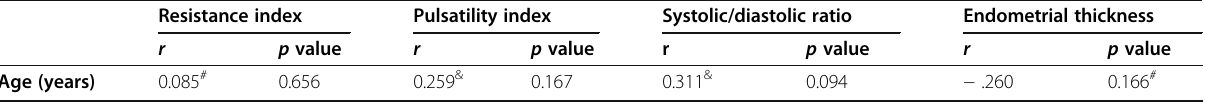
Table 3 Correlation between uterine arteries resistance index, pulsatility index, systolic/diastolic ratios, endometrial thickness, and age of the participants in (fertile) control